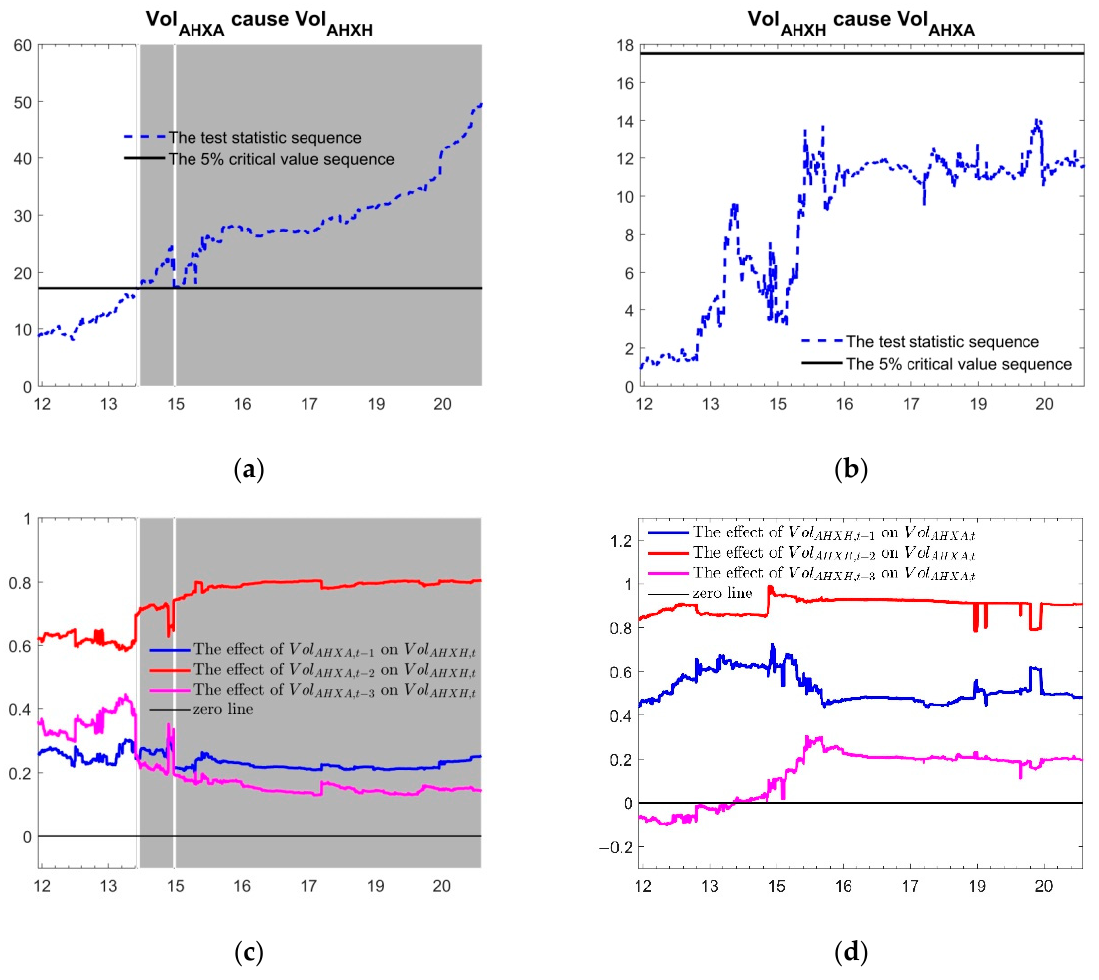
Figure 4. Time varying causalities between AHXA and AHXH at volatility level. ( a ) Graphical results of whether Vol AHXA is a cause of Vol AHXH ; ( b ) Graphical results of whether Vol AHXH is a cause of Vol AHXA ; ( c ) The effect of lag-term Vol AHXA on Vol AHXH ; ( d ) The effect of lag-term Vol AHXA on Vol AHXH